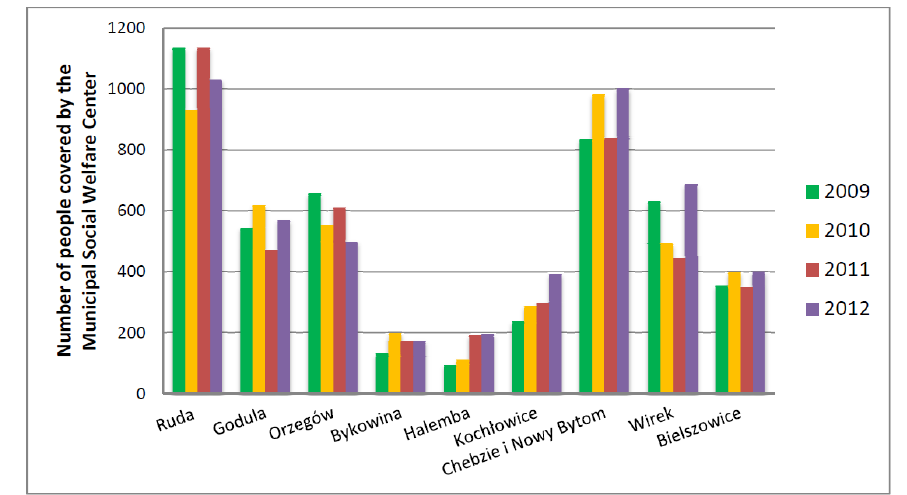
Fig. 6. Number of persons covered by the Social Welfare Centre (MOPS) for poverty in different districts of Ruda Śląska (own study, by